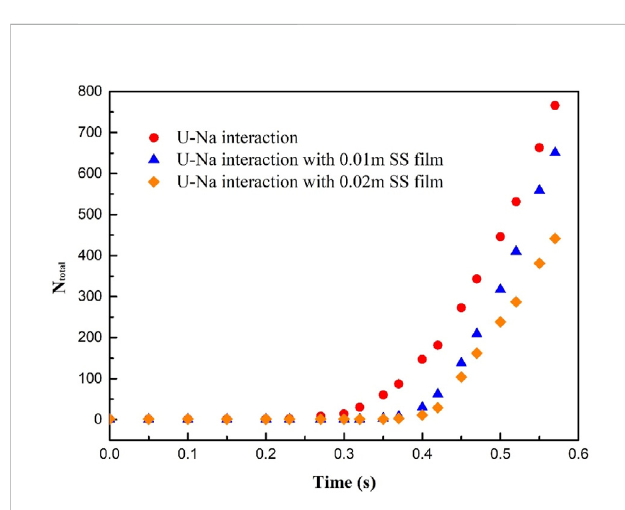
FIGURE 14 The variation of total number of uranium fragments.